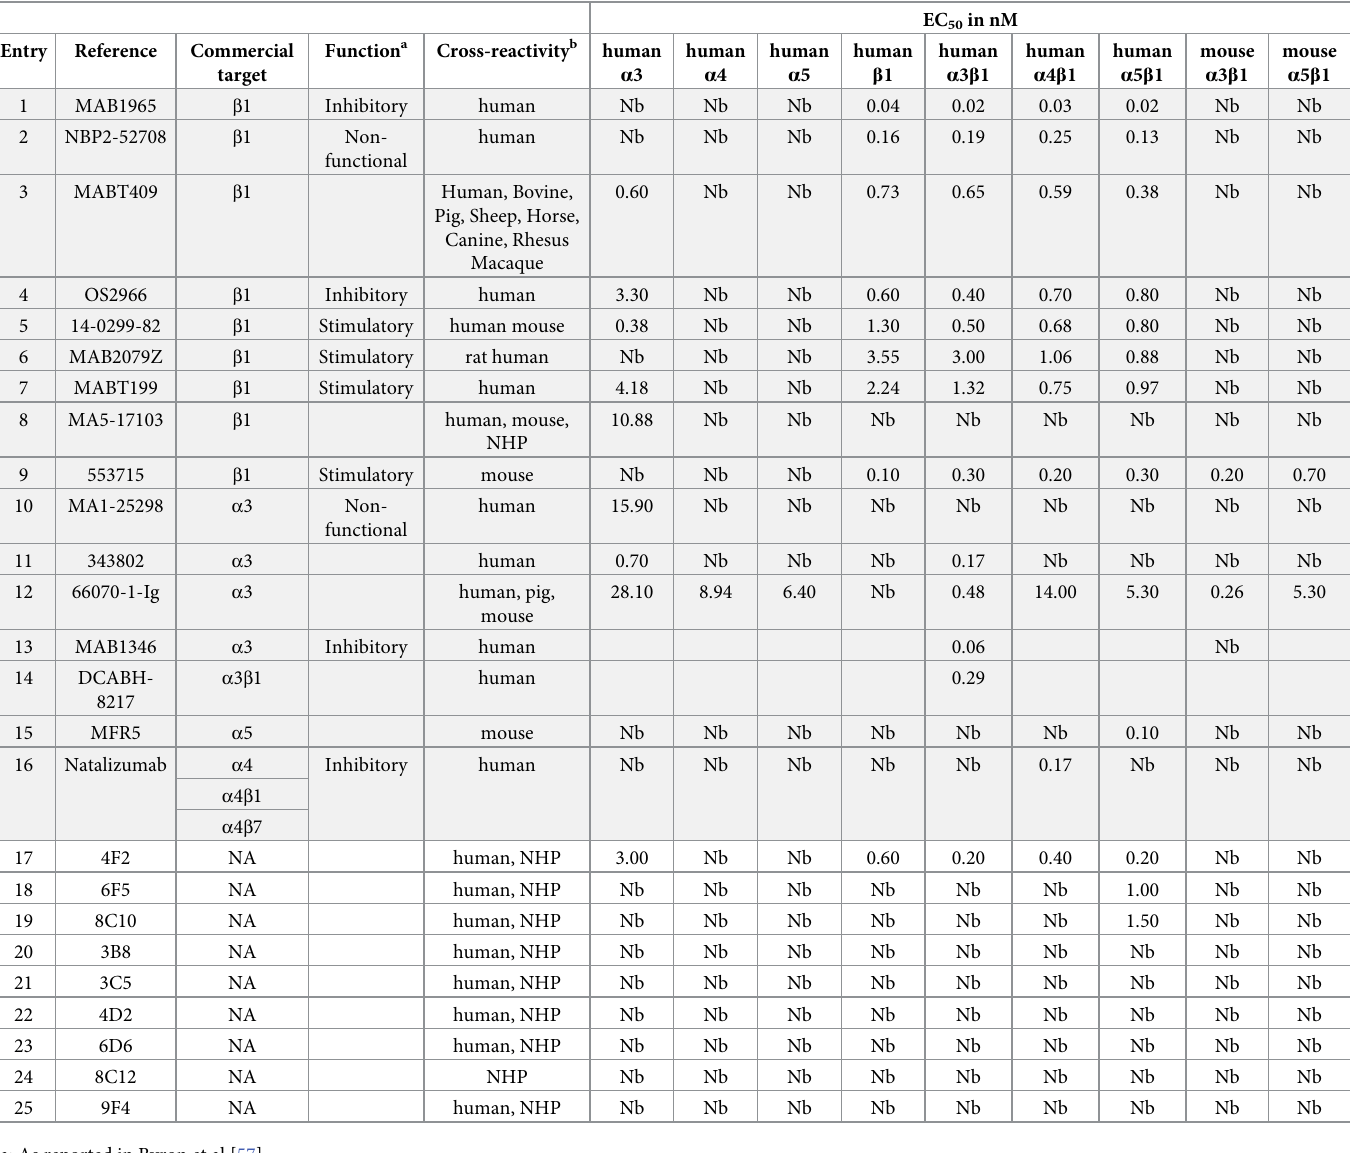
Table 3. Anti-integrin antibodies apparent affinities to different integrin subunits investigated by